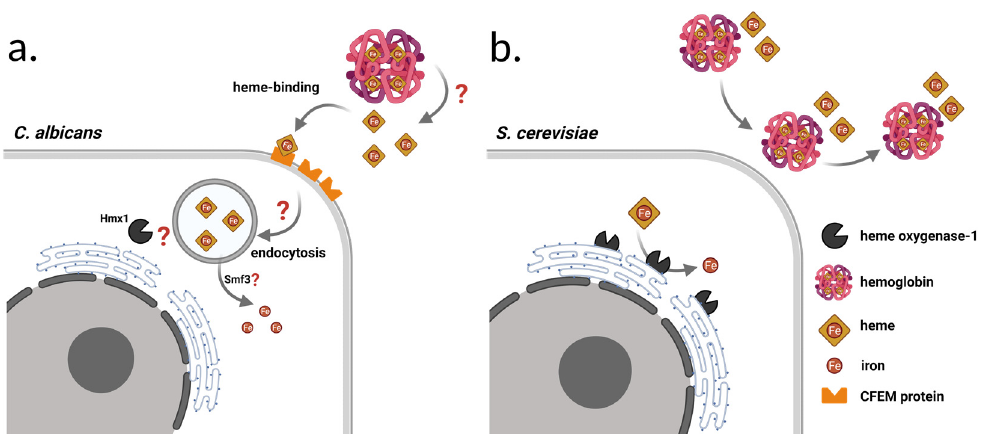
Figure 1. Schematic depiction of free heme and hemoglobin ‐ heme acquisition and utilization in C. albicans and S. cerevisiae : ( a ) C. albicans have heme ‐ binding, GPI anchored CFEM cell surface proteins, with which uptake of external heme is possible through endocytosis. CaHmx1 is able to break down heme; however, several steps of heme ‐ iron utilization have not yet been fully understood (indicated by question marks); ( b ) S. cerevisiae does not have heme ‐ binding cell surface molecules, and thus it is unable to utilize external free heme or hemoglobin ‐ heme. In this yeast, Hmx1 is an ER ‐ bound enzyme that utilizes intracellular heme as an iron source.